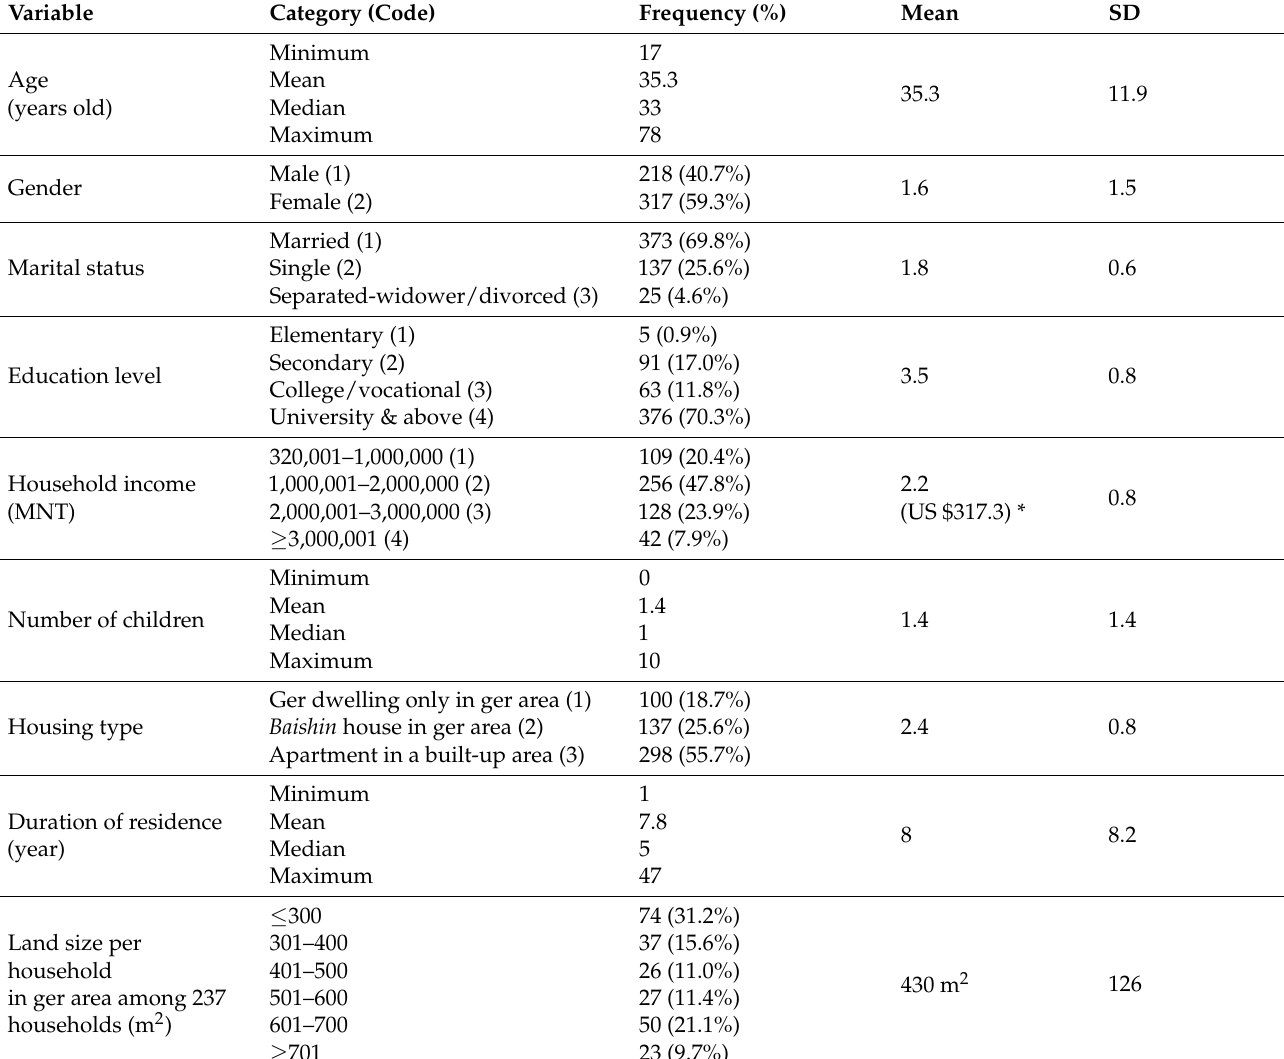
Table 1. Socio-demographic characteristics of the